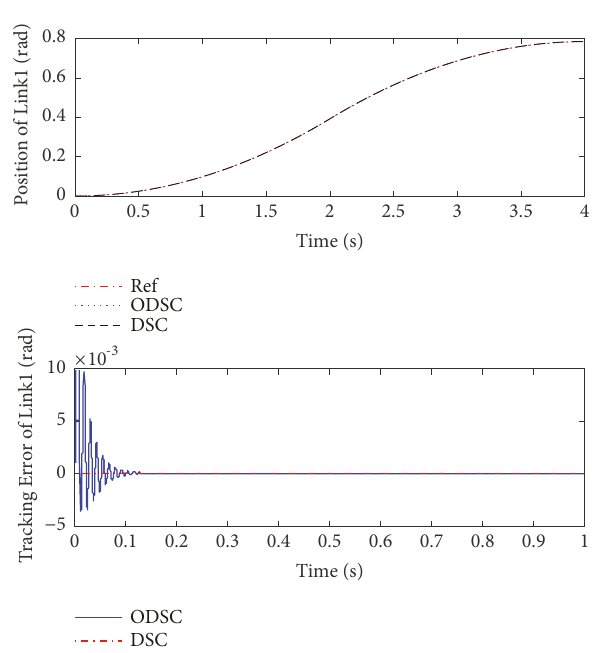
Figure 3: The position and tracking error of